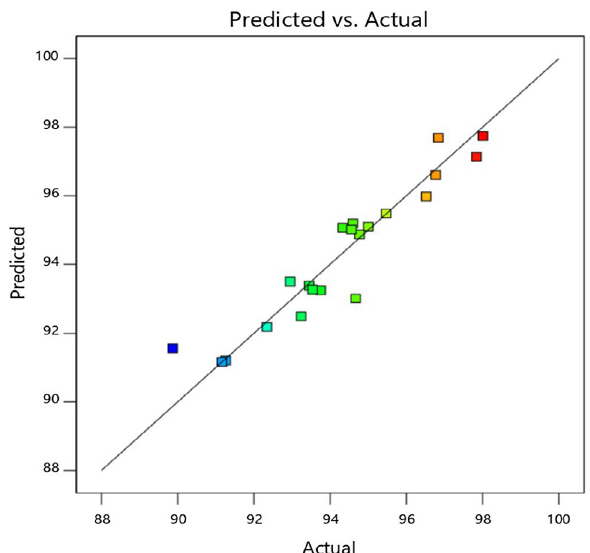
Fig. 17 Plot of actual response versus predicted response for the mal-